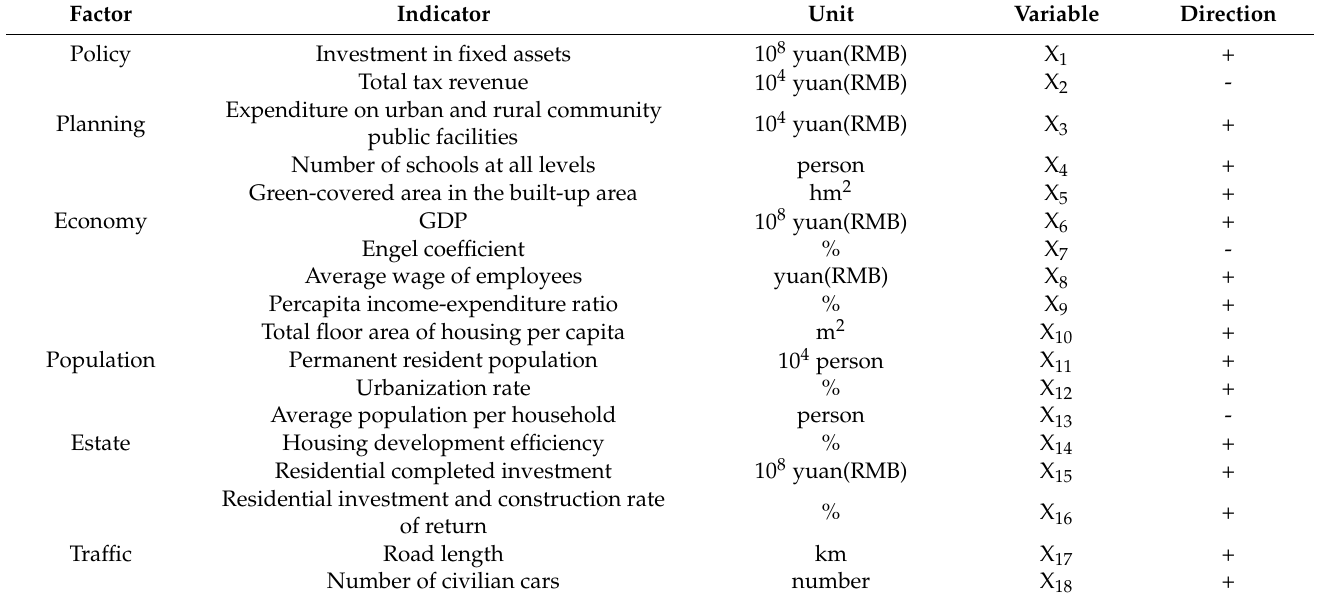
Table 3. Driver selection and